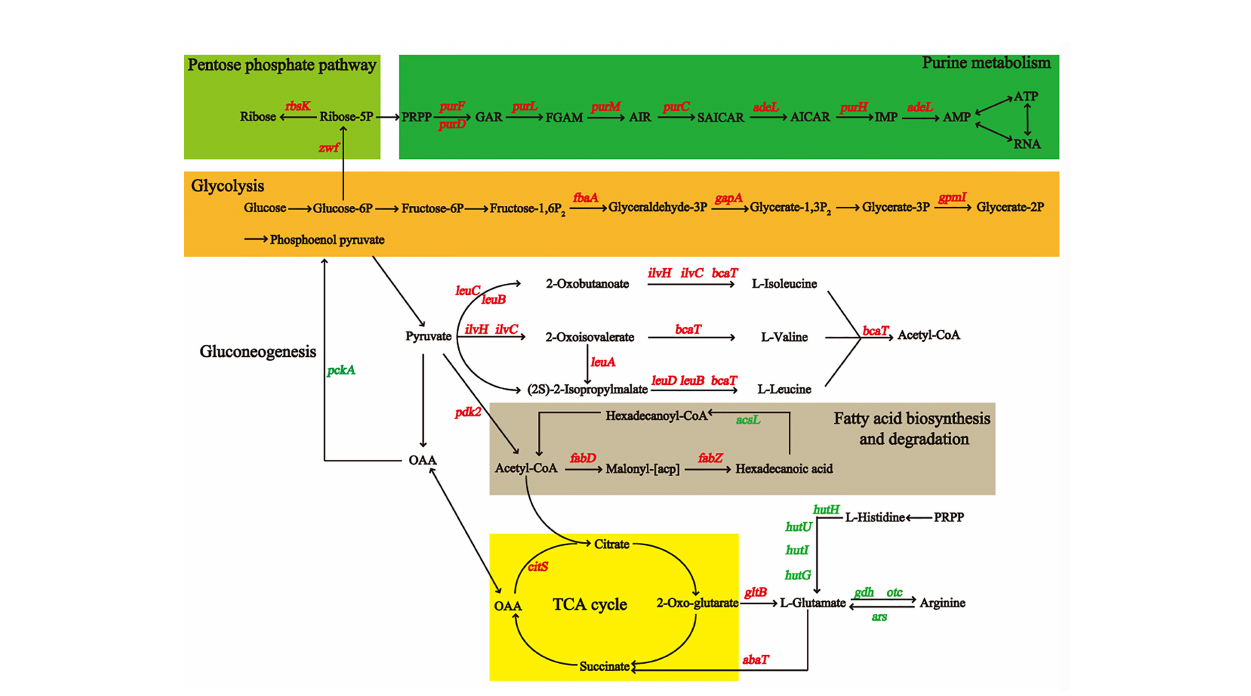
FIGURE 4 | The diagram of metabolic pathways may be affected by addition of sucrose for BaX030, including glycolysis/gluconeogenesis, TCA cycle, pentose phosphate pathway, purine metabolism, fatty acid/amino acid synthesis and metabolism, etc. The marked genes in red corresponding to the proteins were up- regulated, and the green were